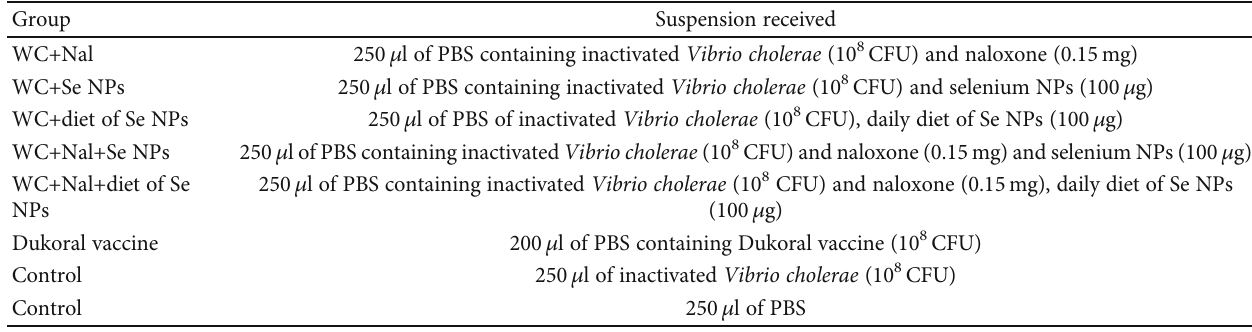
Table 1: Formulation of suspension for each group of